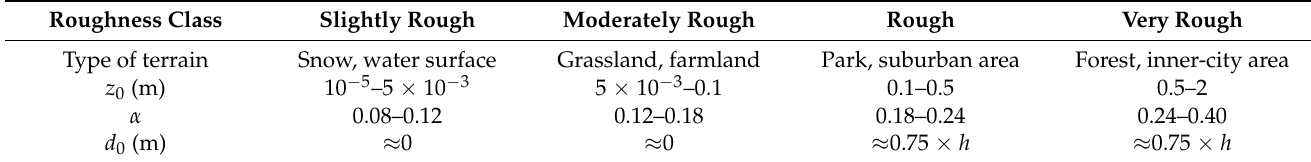
Table 1. Roughness lengths ( z 0 ), profile exponents ( α ), and zero plane displacements ( d 0 ), according to [32]. Roughness Class